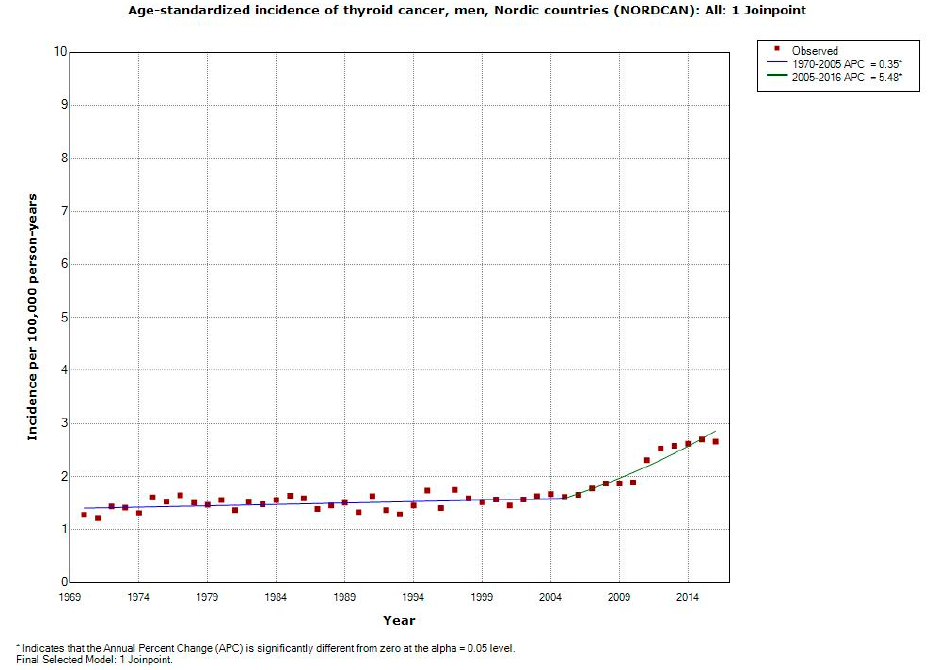
Figure 4. Joinpoint regression analysis of age-standardized incidence of thyroid cancer for men, all ages 1970–2016. Incidence per 100,000 inhabitants for ICD-10 code C73 in the Nordic countries according to NORDCAN (https://www-dep.iarc.fr/NORDCAN/english/frame.asp).